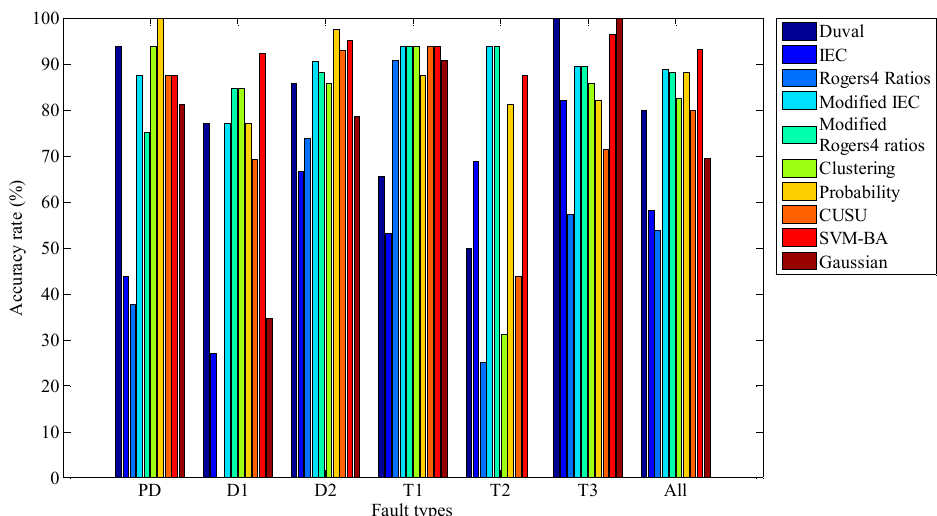
Figure 9. Histogram of accuracy rates.